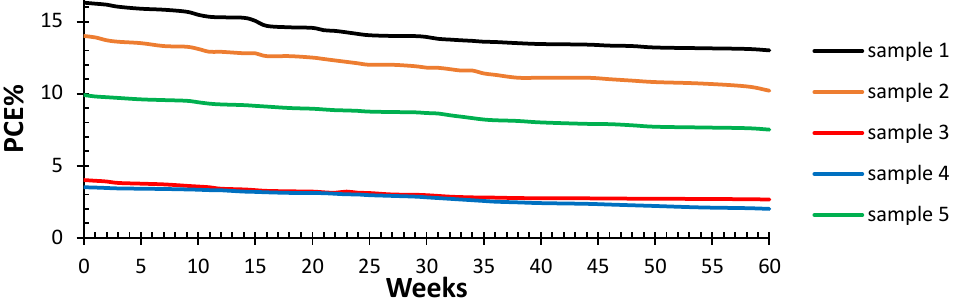
Figure 12. Devices stability testing results by measuring variations in the efficiency of the perovskite solar cells over a 60-week period. Devices were kept in an ambient laboratory condition and tested under a 100 mW/cm 2 illumination using ABET AM 1.5 G sunlight simulators with a reference cell as a control.